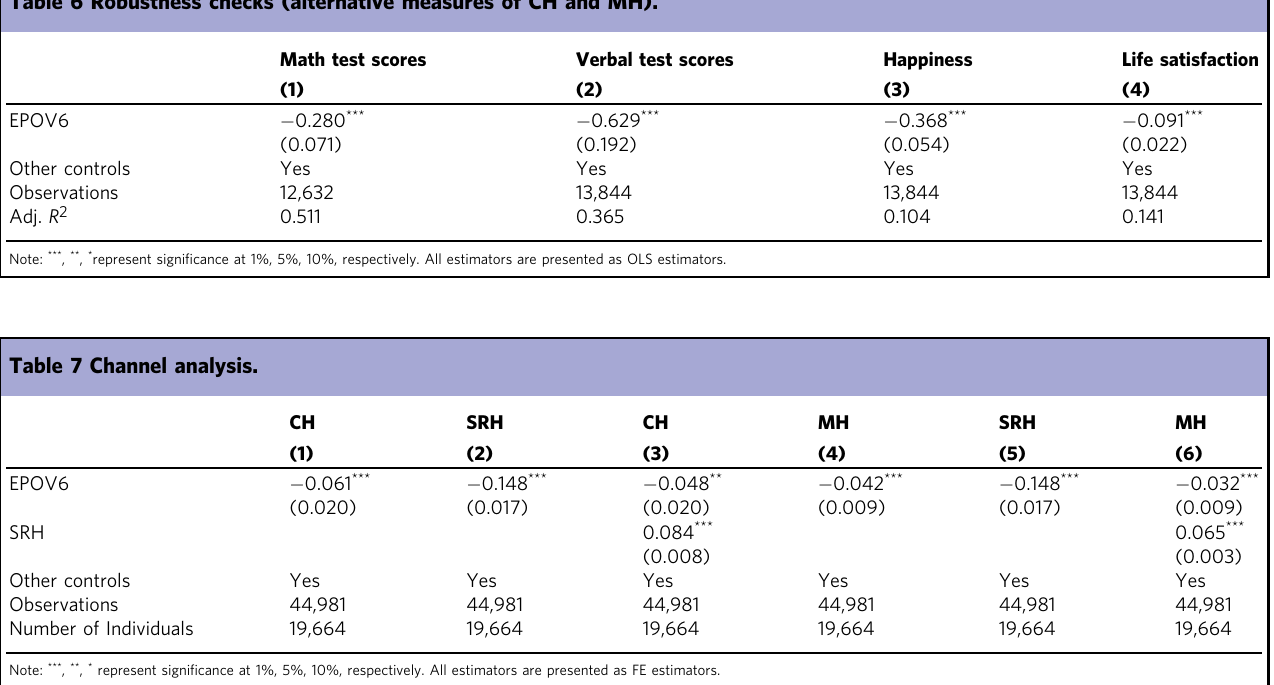
Panel B: Using “ MH ” as a dependent variable EPOV1